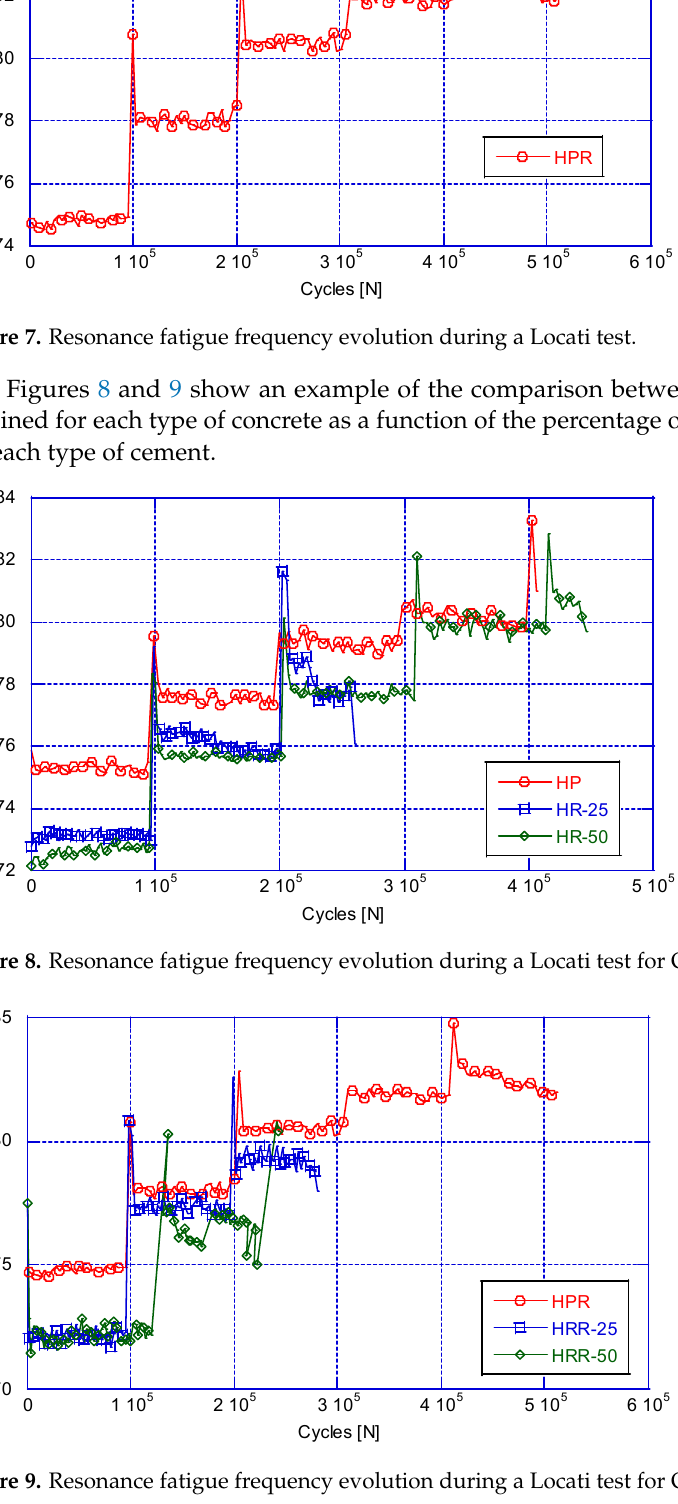
Figure 9. Resonance fatigue frequency evolution during a Locati test for OPC-25CDW mixes. Figure 7 shows the results for the OPC concretes. It can be seen that the behavioural phases described above were satisfied. As the percentage of replacement increased,